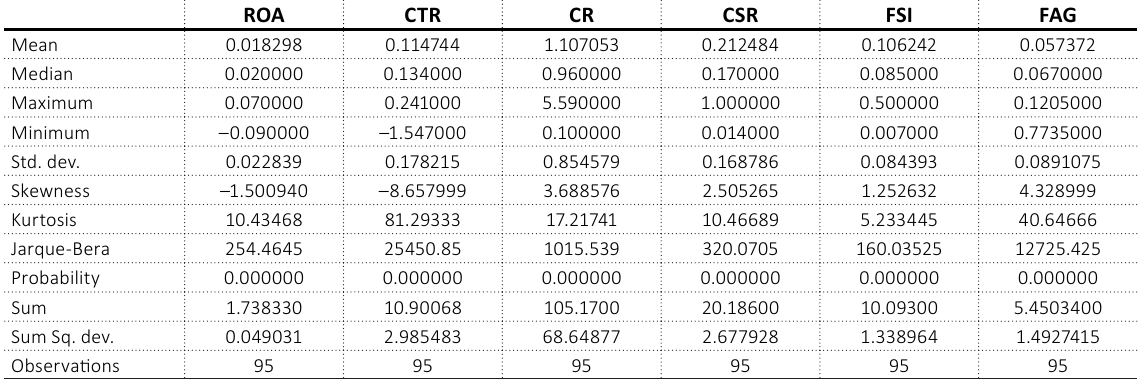
Table 1. Results of the empirical model analysis using descriptive statistics